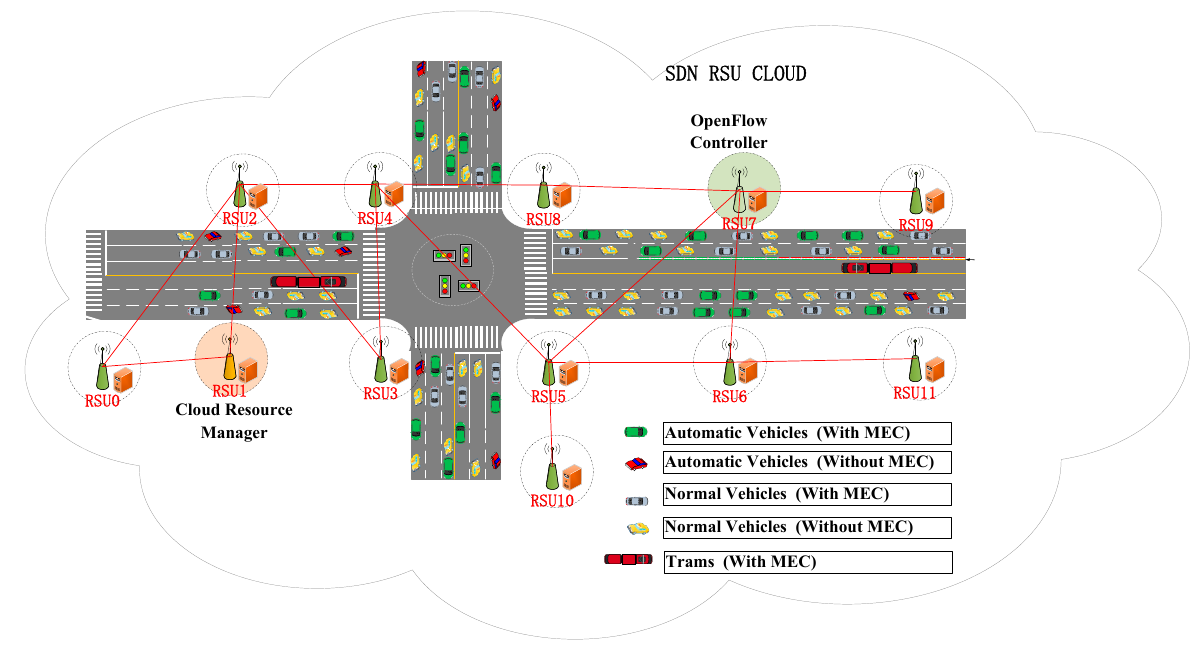
Figure 3. Detailed RSU cloud topology.